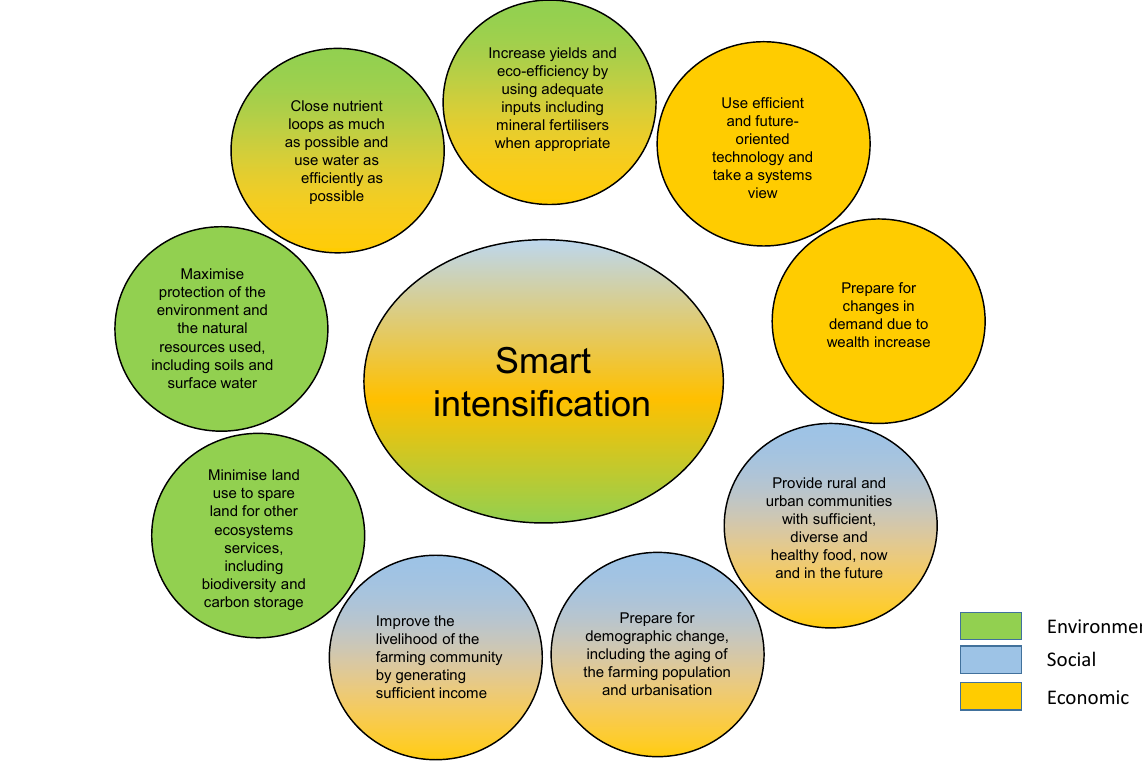
Figure 2. Different aspects of smart agricultural intensification. Colouring refers to main reason as to why each aspect is